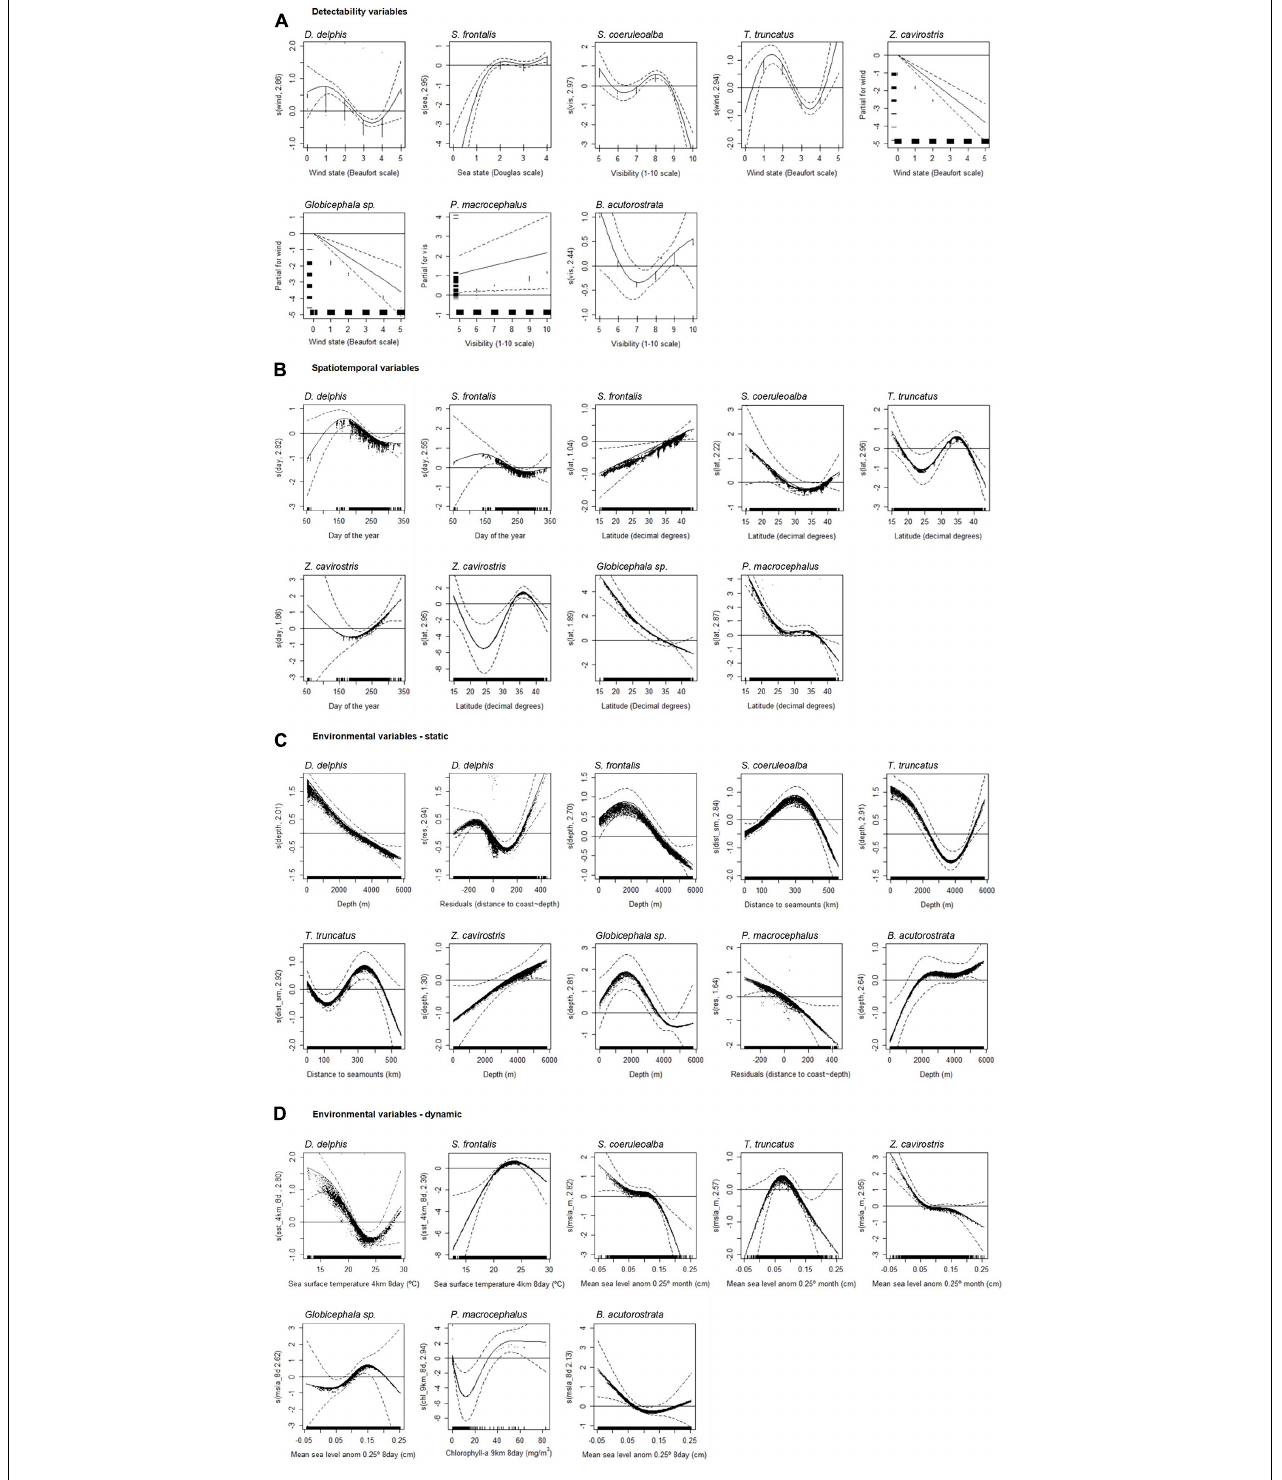
FIGURE 1 | GAM fitted splines of the response variable species presence as a function of the explanatory variables for the environmental model produced for the eight most frequently sighted species. The degrees of freedom are shown in brackets on the y -axis. Tick marks above the x -axis indicate the distribution of observations. Dashed lines delimit the 95% confidence intervals of the spline functions and dots on the graph area represent the residuals. lat—latitude, wind—wind state in the Beaufort scale, dist_sm—distance to seamounts, chl—chlorophyll-a, msla—mean sea level anomalies. (A) Detectability variables; (B) spatiotemporal variables; (C) environmental static variables; (D) environmental dynamic